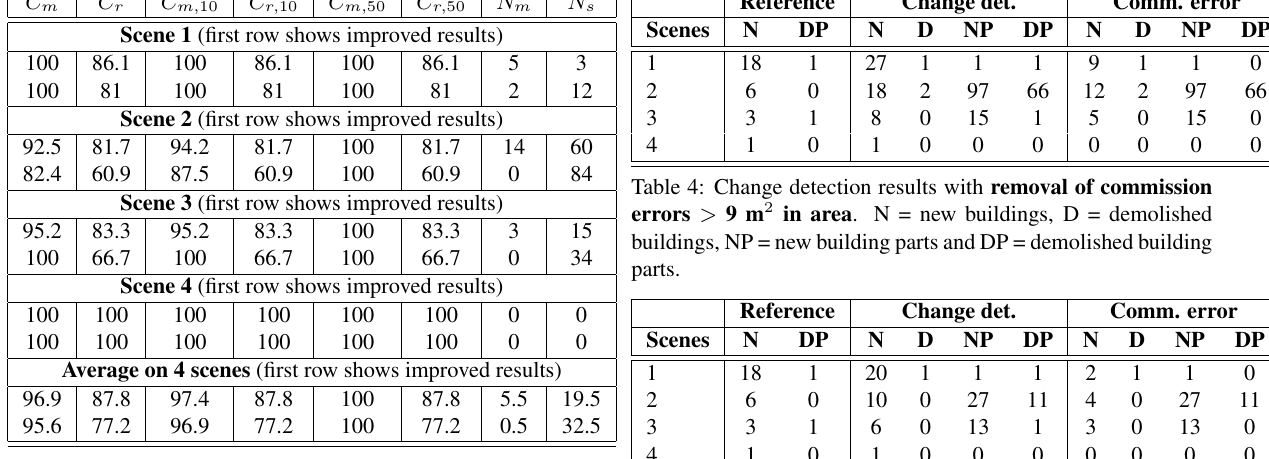
Table 3: Comparing object-based building detection results in December data sets with and without the application of the pro- posed improvement. C m = completeness and C r = correctness ( C m, 10 , C r, 10 and C m, 50 , C r, 50 are for buildings over 10 m 2 and 50 m 2 , respectively) are in percentage. N s = number of split op- erations and N m = number of merge operations.